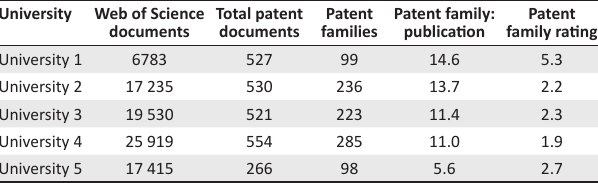
TABLE 1: Patent family to publication output comparison, and patent rating for top five innovative South African